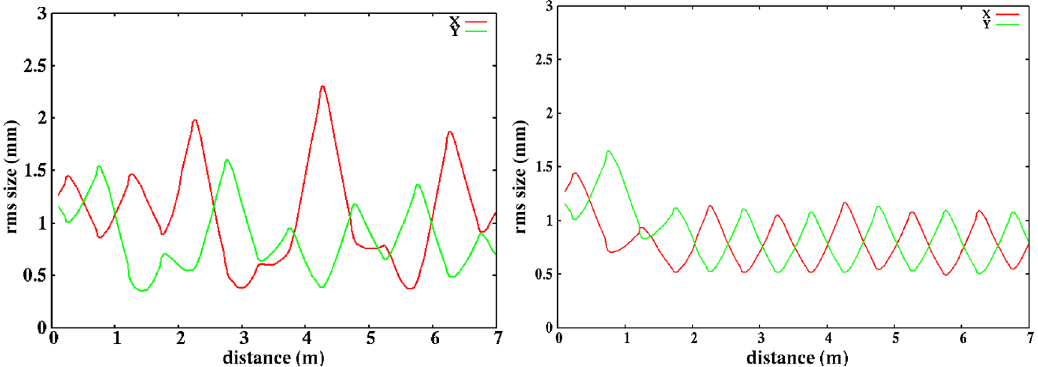
FIG. 5. Transverse rms size evolution without the quadrupole matching (left) and with the quadrupole matching including the space- charge effects (right) through the FODO